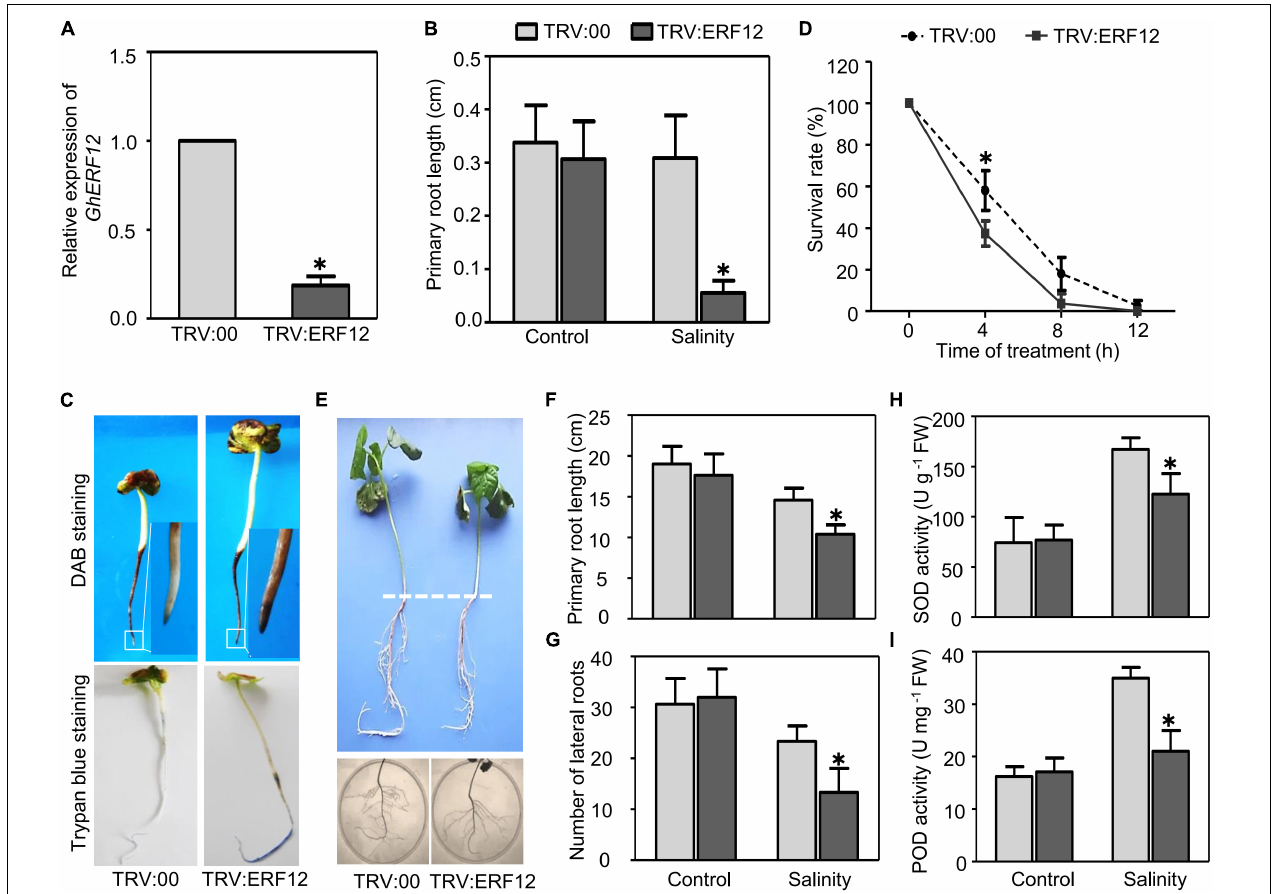
FIGURE 6 | Silencing of GhERF12 in cotton increased sensitivity to salinity. (A) Relative abundance of GhERF12 transcripts in GhERF12 -silenced (TRV:ERF12) and control (TRV:00) plants were analyzed with qRT-PCR after 10 days inoculation. GhActin9 was used as an internal control. Data represent means ± SD ( n = 6) from three independent replicates. (B) Length of primary roots in GhERF12 -silenced and control plants treated with 100 mM NaCl were measured at the indicated time. (C) DAB and Trypan blue stain analysis were used to quantify ROS accumulation and cell death after salinity stress. (D) Survival rate of roots from GhERF12 -silenced and control plants. (E) GhERF12 -silenced and control adult plants (30-day old) treated with 250 mM NaCl for 7 days. (F) Root length and (G) number of lateral roots in GhERF12 -silenced and control adult plants. (H) Activity of SOD and (I) POD in GhERF12 -silenced and control plants after 250 mM NaCl treatment for 8 h. The data are means ± SD ( n = 10). The asterisk ( ∗ ) indicate significant differences at P < 0.05 ( t -test). All experiments were performed in